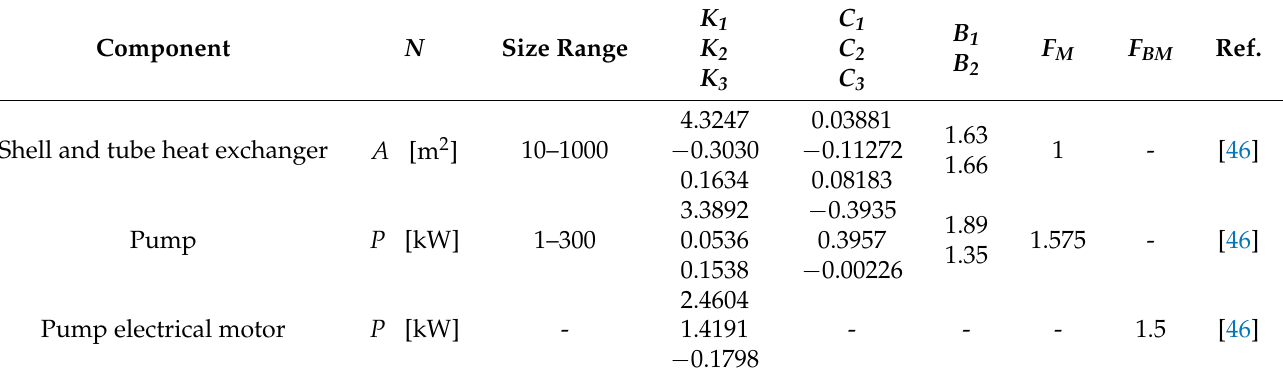
Table A2. Parameters and range of applications used in the equations.